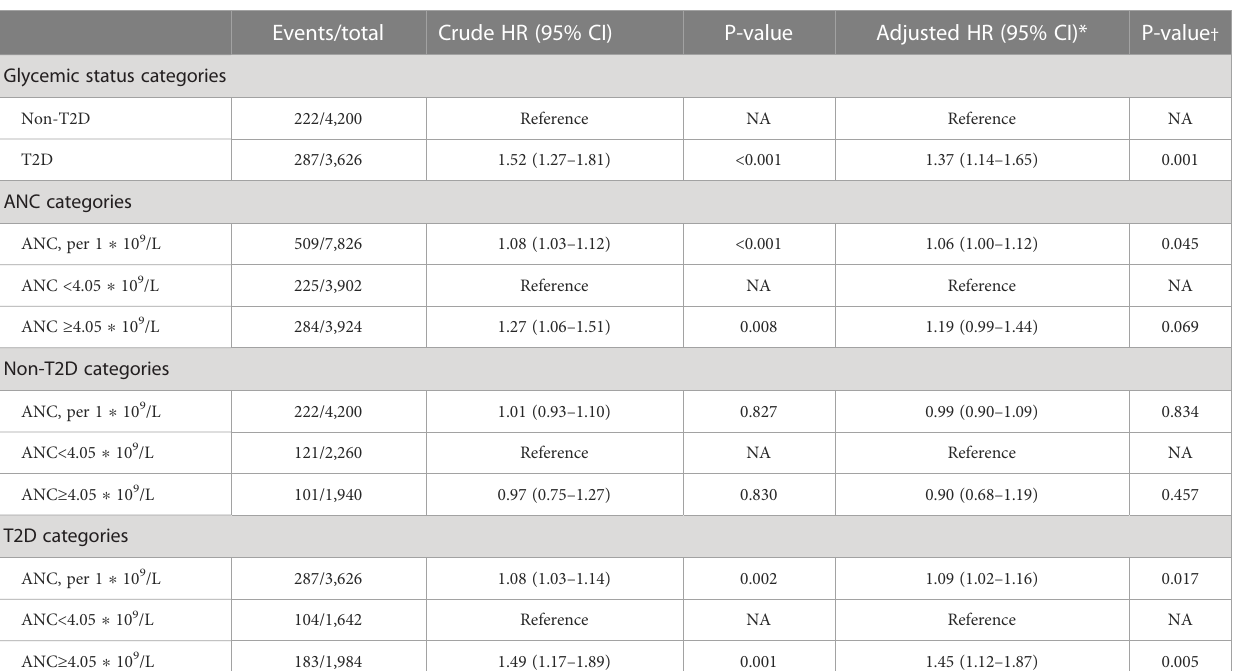
TABLE 3 Prognostic value of ANC for MACCEs according to different glycemic